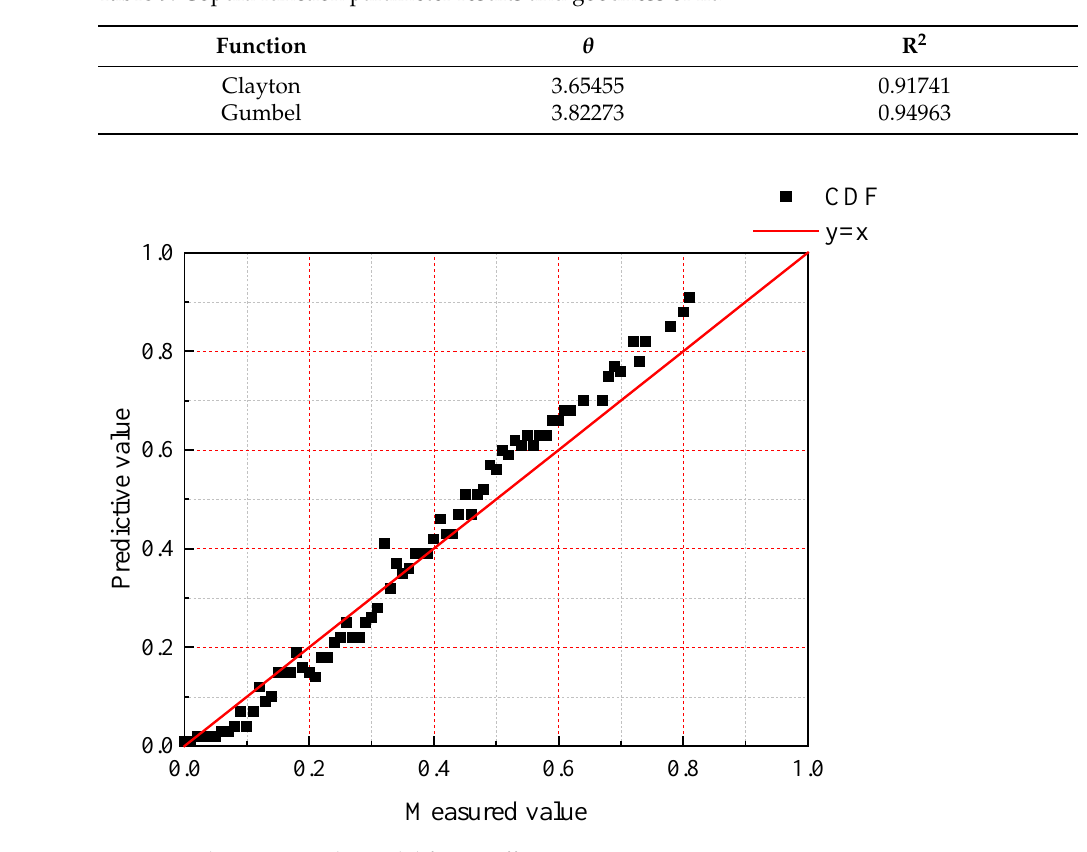
Figure 7. The AL–Copula model fitting effect.